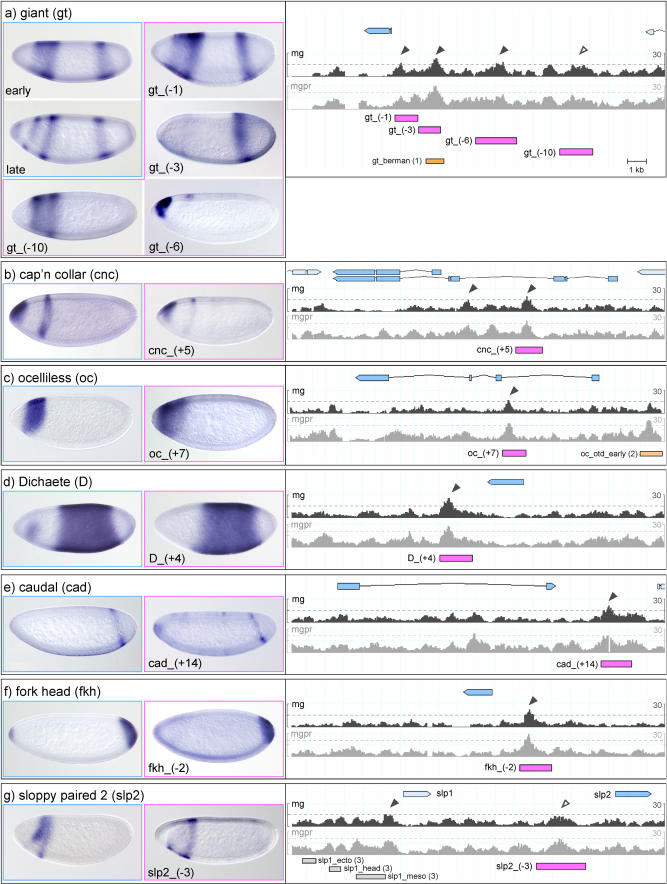
Expression Patterns Driven by Ahab-Predicted Modules IAhab-predicted modules in the control region of gap and pair-rule genes were tested by fusing putative modules to a basal promoter driving lacZ (module-basal promoter-lacZ; Thummel and Pirrotta 1991). The genomic regions, with free energy profiles, for two Ahab runs (mg and mgpr) are shown on the right. The free energy cutoffs are marked by dotted lines; mg run predictions with scores greater than 15 are marked by black arrowheads, tested subthreshold peaks with scores below 15 by open arrowheads. The transcribed region of the locus is marked in blue, the experimentally tested genomic regions are marked by pink bars and named according to distance from transcription start site to middle of the enhancer, and previously known modules are marked by orange bars. The endogenous gene expression is shown on the left (blue frame), the expression pattern driven by the module(s) in the center (pink frame). Embryos are oriented anterior to left, dorsal up. In a few cases, the patterns driven by Ahab-predicted modules are unfaithful to the endogenous gene expression; we distinguish “unfaithful” and insertion-dependent “unstable” patterns. For further description see text. (A) gt, (B) cnc, (C) oc, (D) D, (E) cad, (F) fkh, and (G) slp2. References: (1) Berman et al. (2002), (2) Gao and Finkelstein (1998), (3) Lee and Frasch (2000), and (4) Pankratz et al. (1992) and Rivera-Pomar et al. (1995).